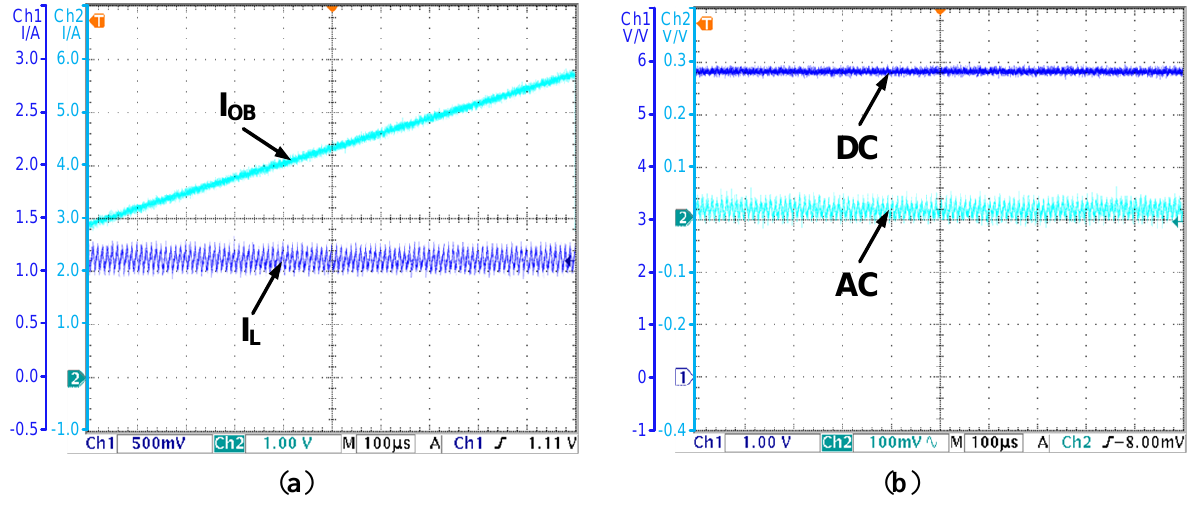
Figure 8. ( a ) The observed current and the inductor current—the CO based PCC